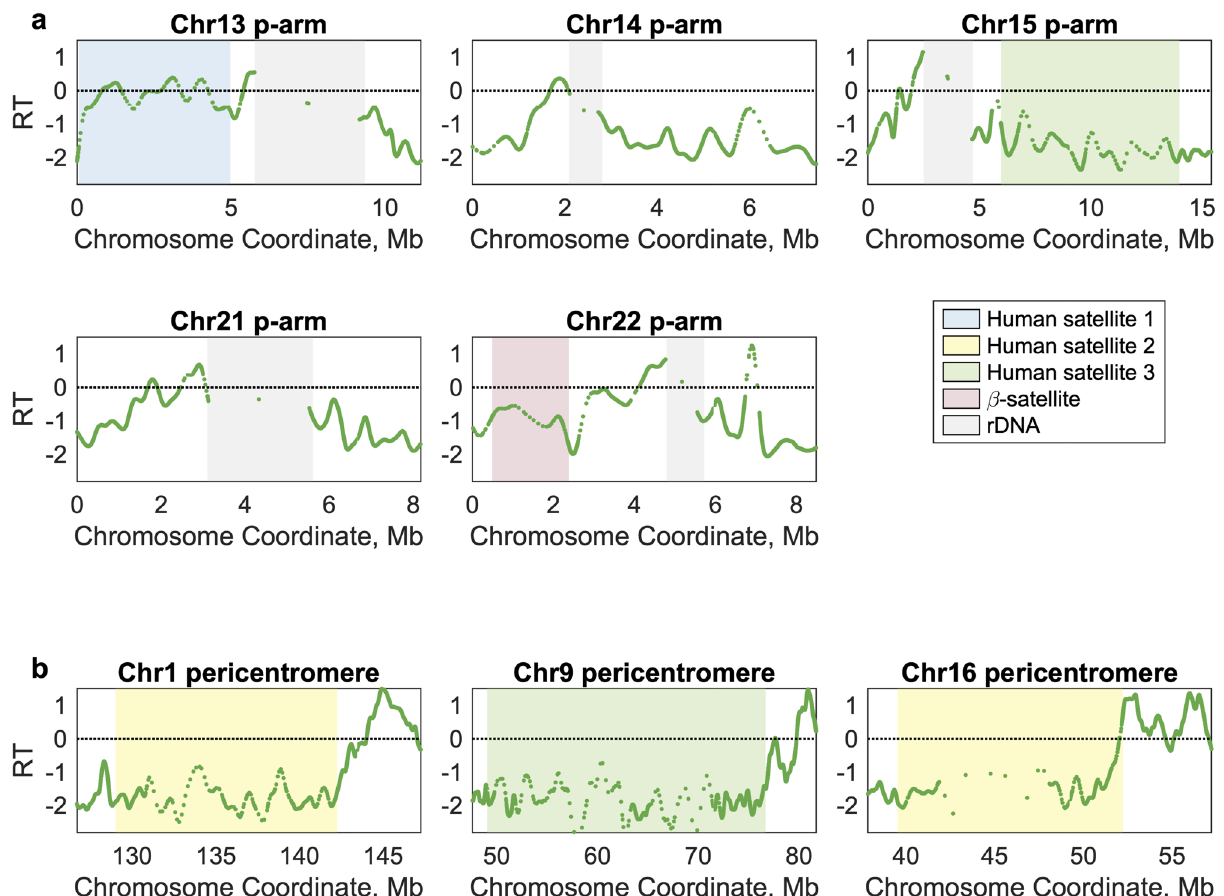
Figure 2. Replication timing (RT) of previously unresolved regions of the human genome. ( a ) RT profiles for the five acrocentric p-arms. rDNA arrays (gray) remain as gaps in the profile. Regions shown span from the telomere to 5 Mb upstream of the start of the p-most α-satellite higher-order repeat. ( b ) RT profiles for the large heterochromatin arrays neighboring the centromeres on the q-arms of chromosomes 1, 9, and 16. Regions shown span from the end of q-most α-satellite higher-order repeat to 5 Mb downstream of the last annotated satellite. The RT profile for the lymphoblastoid cell line GM12878 is shown for each region. rDNA loci and satellite arrays larger than 1 Mb are indicated in colored